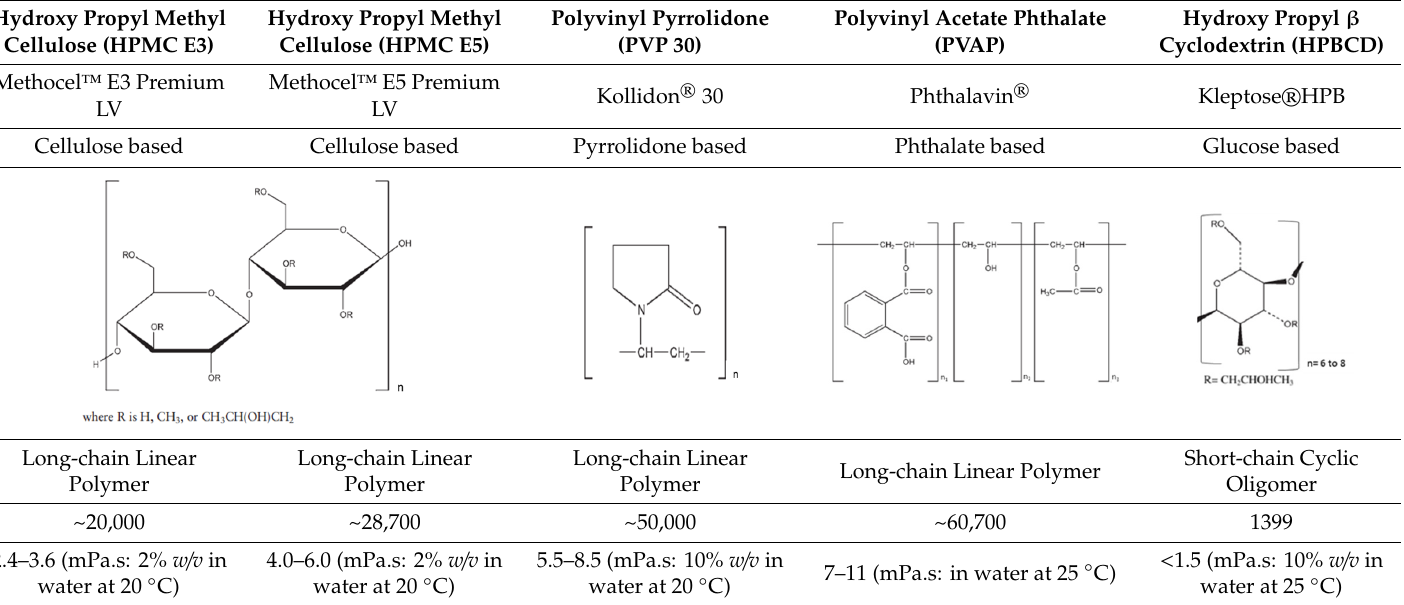
Table 1. Primary polymers/Oligomers selected for development of binary KSDs of abiraterone [35,45–47].